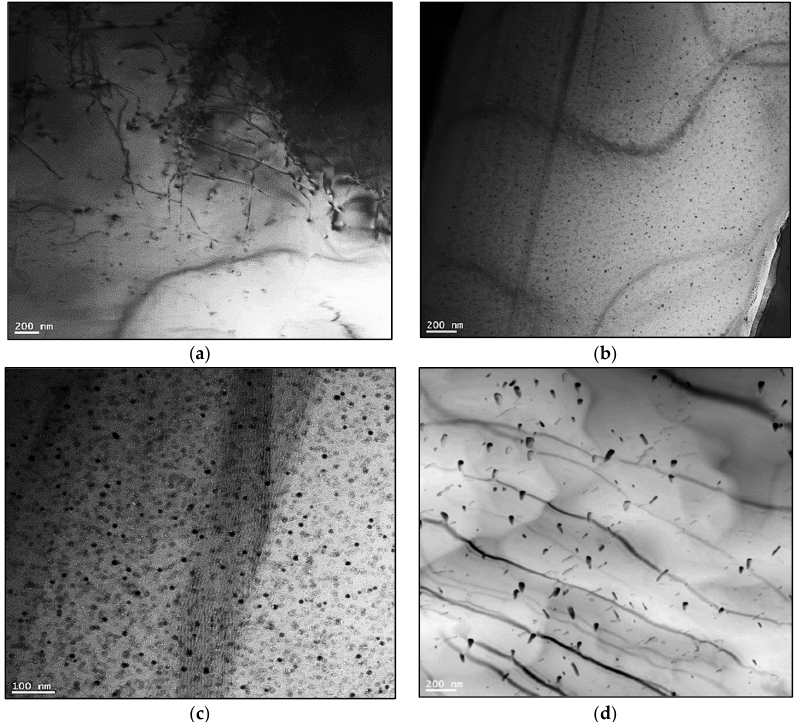
Figure 13. Bright field TEM images of precipitation during heat treatment of Sr-modified M4S alloy following ( a ) solution heat treatment, ( b ) T5 temper, ( c ) T6 + 8 h/250 ◦ C, ( d ) T6 + 200 h/250 ◦ C. Note the progress in the size and density of precipitated phase particles (Al 2 Cu) on going from one treatment to